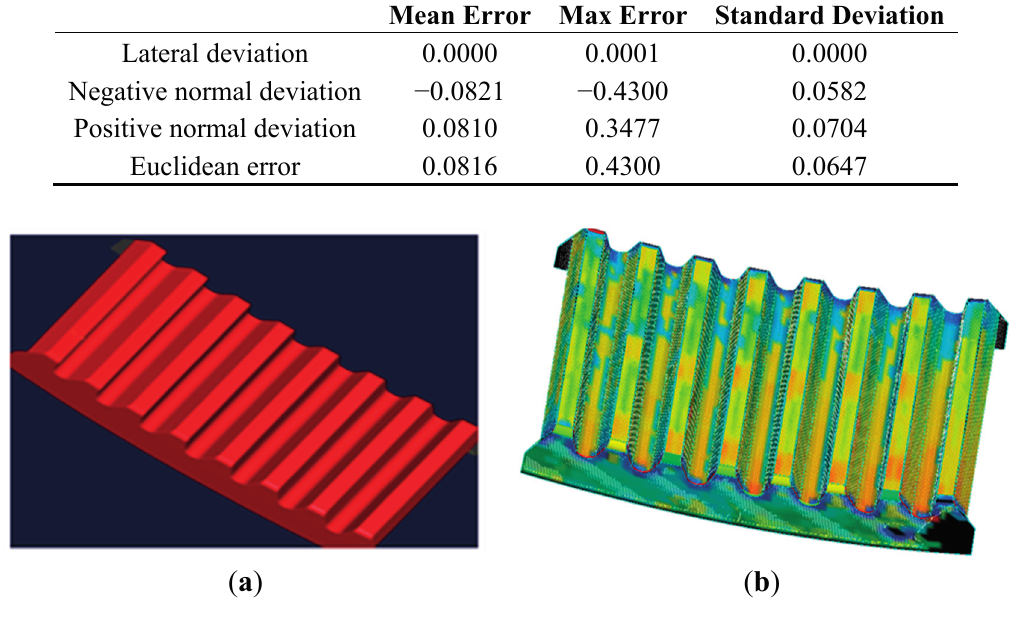
Figure 15. ( a ) The fitting surface; ( b ) Error distribution